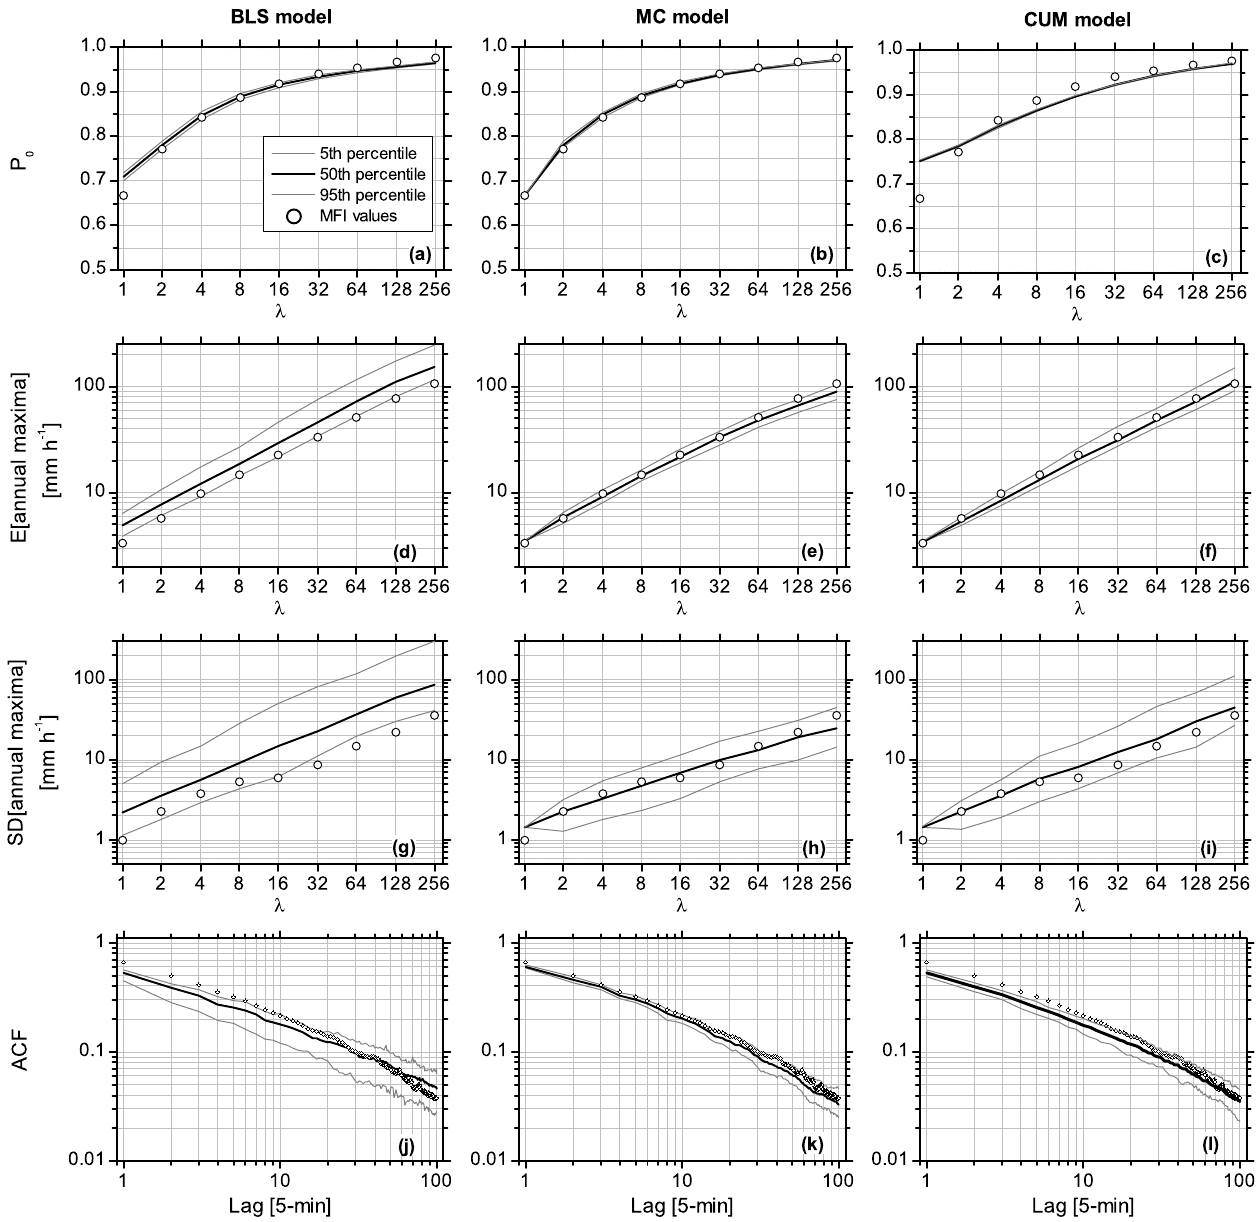
Fig. 8. Physical summary statistics computed on 100 series simulated by BLS, MC, and CUM models. (a)–(c) Probabilities of zero rainfall P 0 . (d)–(f) Mean E [·] of annual maxima. (g)–(i) Standard deviation SD [·] of annual maxima. (j)–(l) Autocorrelation function. Grey lines denote the patterns of the median of each statistics computed on 100 simulations, while light grey lines are the 5th and 95th